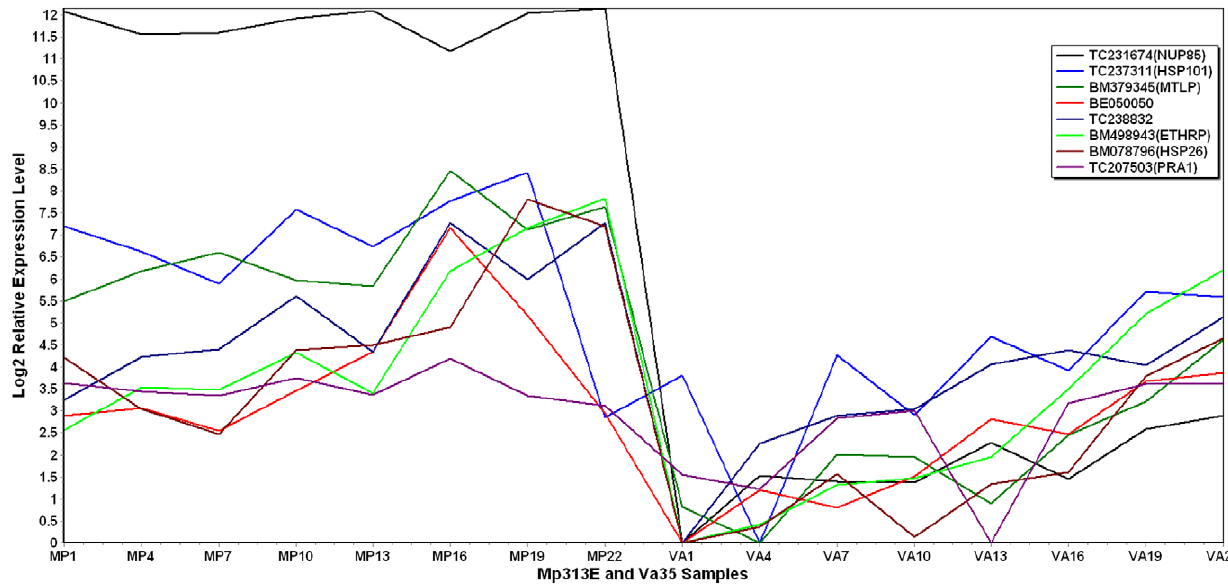
Figure 5. 2D plot showing gene expression levels over a period of 21 days after the fungal inoculation. These genes are highly expressed in Mp313E than in Va35.